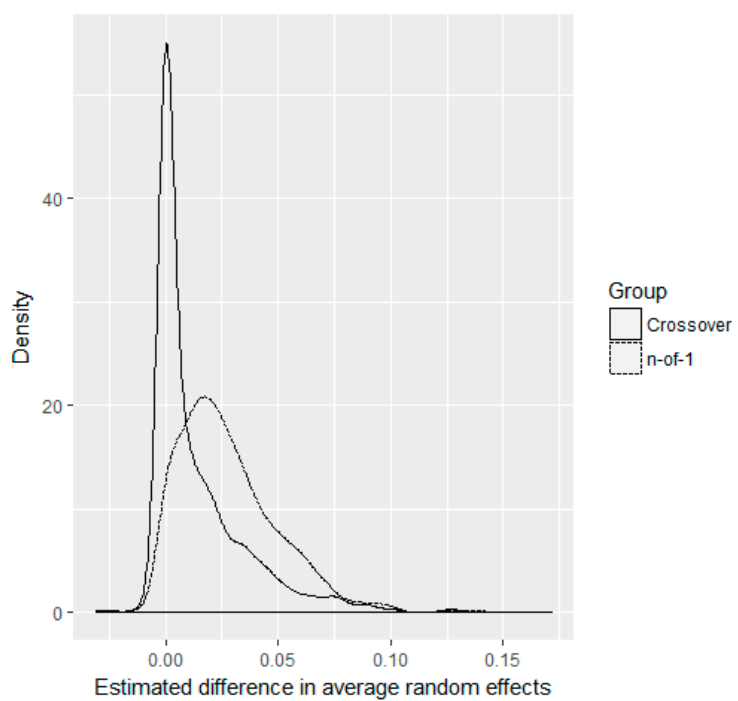
Figure 7. Average estimated random effect differences between non-representative and representative patients. Densities are shown for scenario one with 𝑝 = 0.5 , 𝑛 = 100 , and 1000 simulations for N-of-1 and crossover designs.